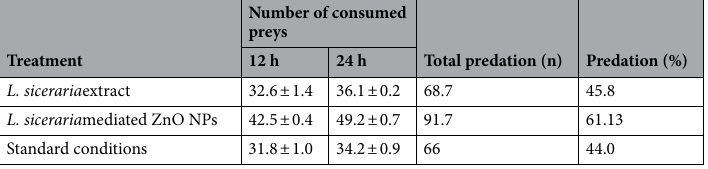
% of suppression of parasitemia at 48